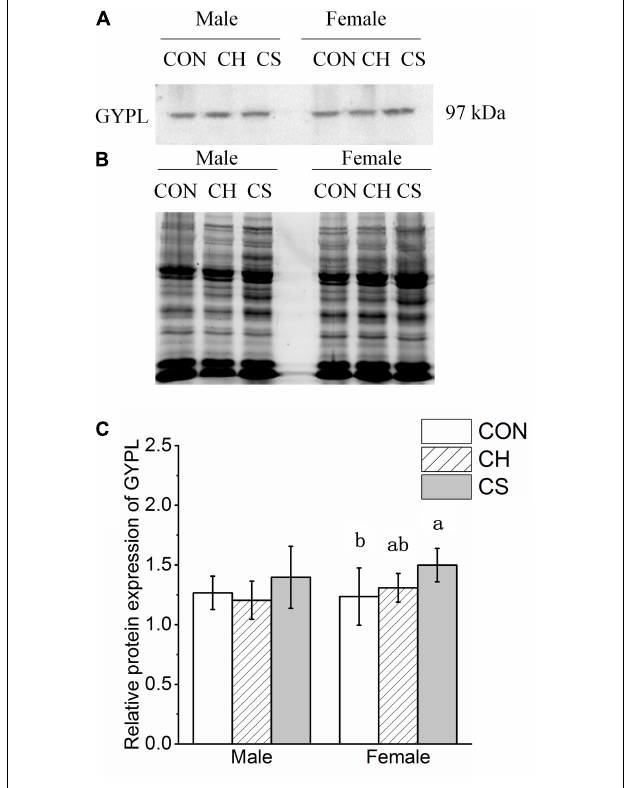
FIGURE 6 | Changes in protein expression levels of glycogen degradation-related factors in cardiac muscle of Brandt’s voles. (A) Representative immunoblots of GYPL in cardiac muscle. (B) Representative polyacrylamide gel of total protein. (C) Relative protein expression of GYPL. Values are mean ± SD. n = 8. CON, control group; CH, cool huddling group; CS, cool separated group. Different letters identify statistically significant differences among temperature treatment groups ( P <